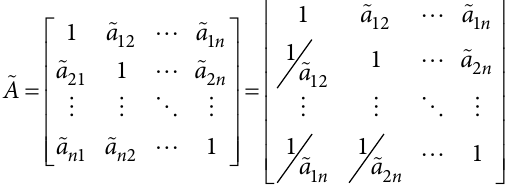
Table 1. Definition and the scale of the linguistic variables Fuzzy number